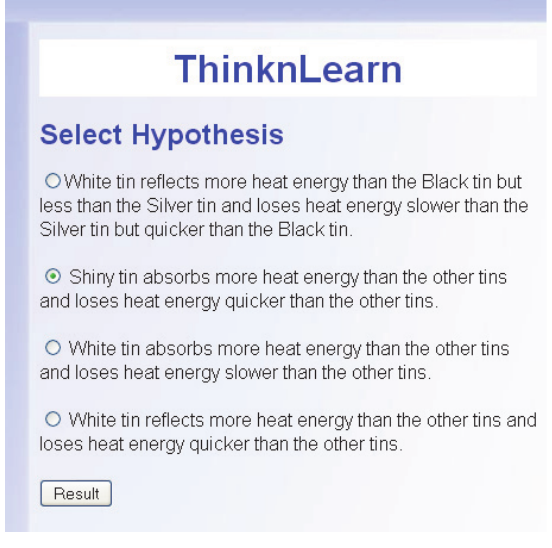
Figure 13 . Hypothesis